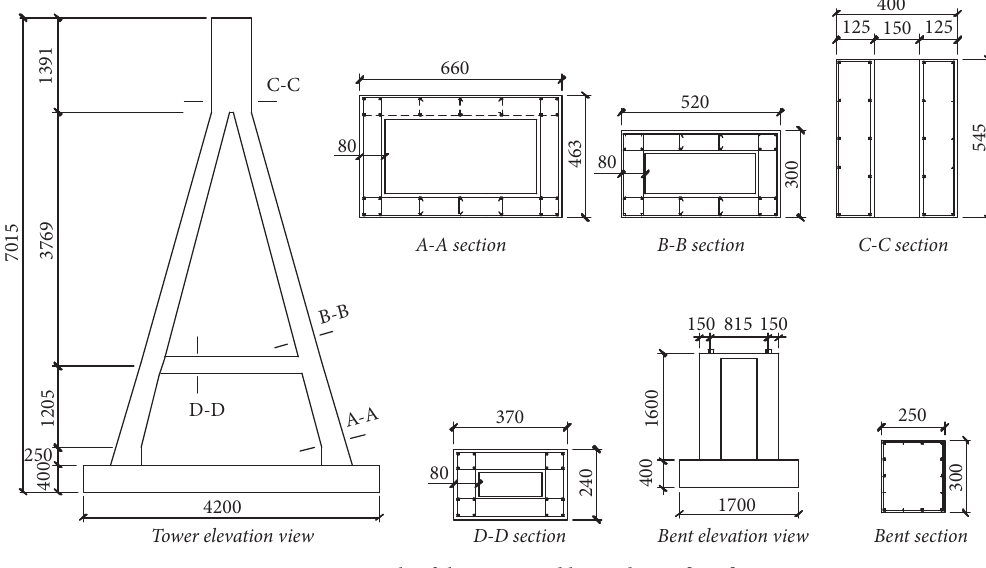
Figure 3: Details of the tower and bents design [mm].